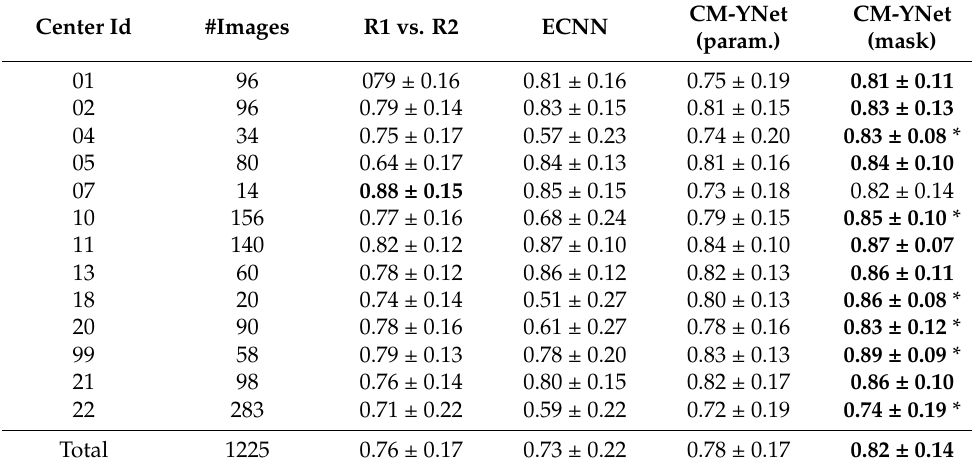
Table 3. Comparison of DICE scores according to the different acquisition